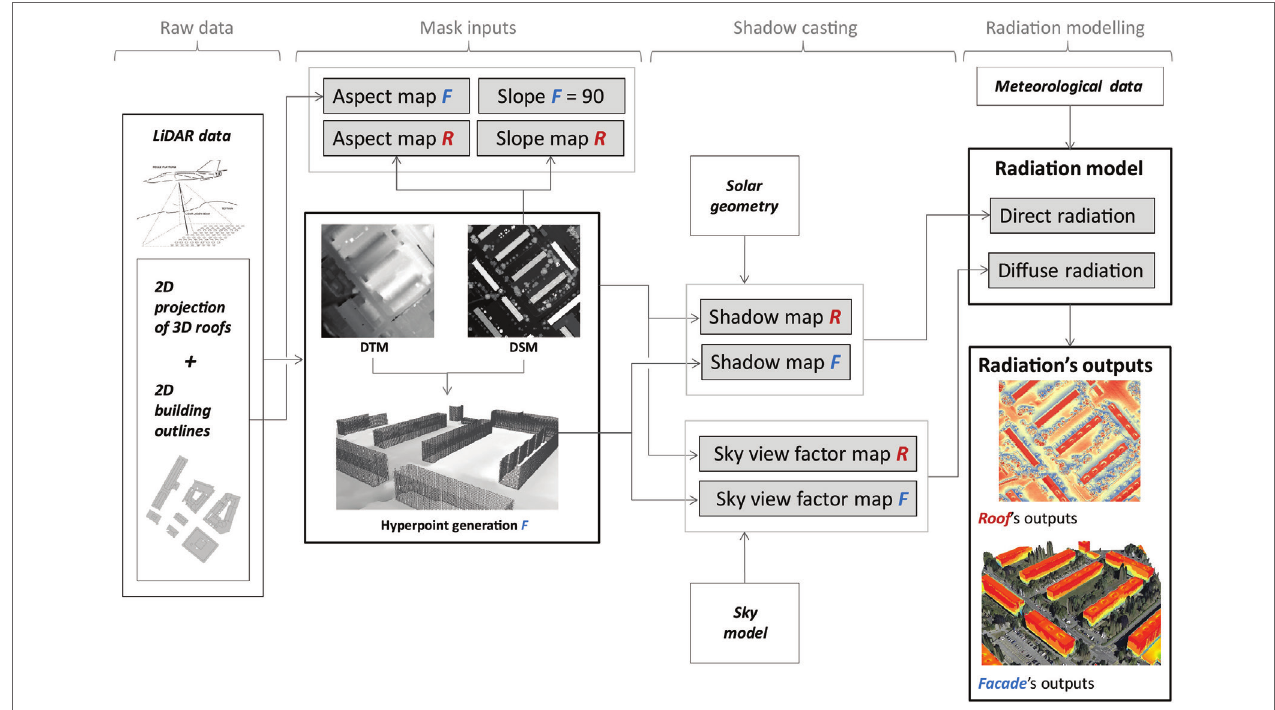
FIGURe 1 | Workflow for the calculation of solar radiation on roofs (R) and facades